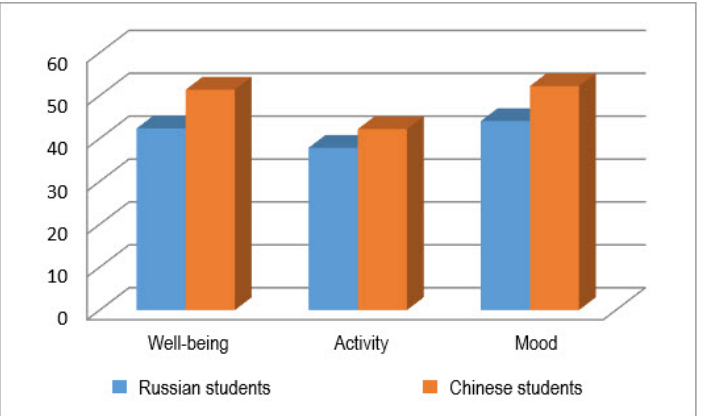
Figure 2. Results of the “Well-being, activity, mood” symptomatic questionnaire application (Russian and Chinese students